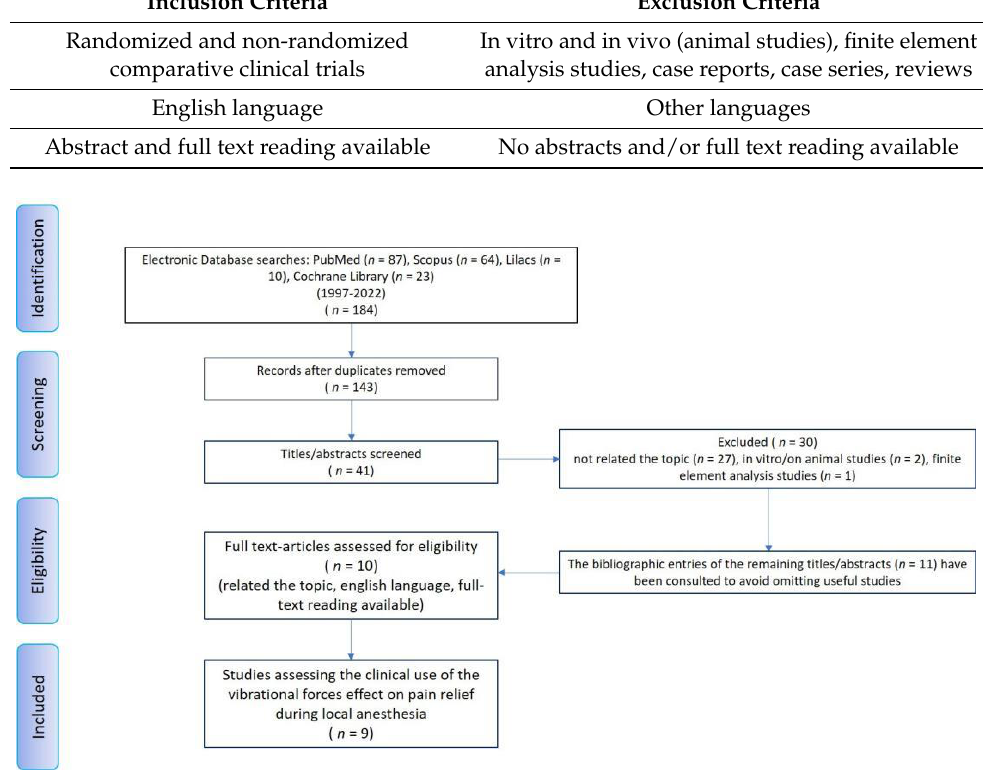
Figure 1. Review flow diagram for the scoping review detailing the database searches, the number of abstract screened, and the full texts retrieved. Table 1. Research question based on the PCC (Population/Problem, Concept, Context) strategy.